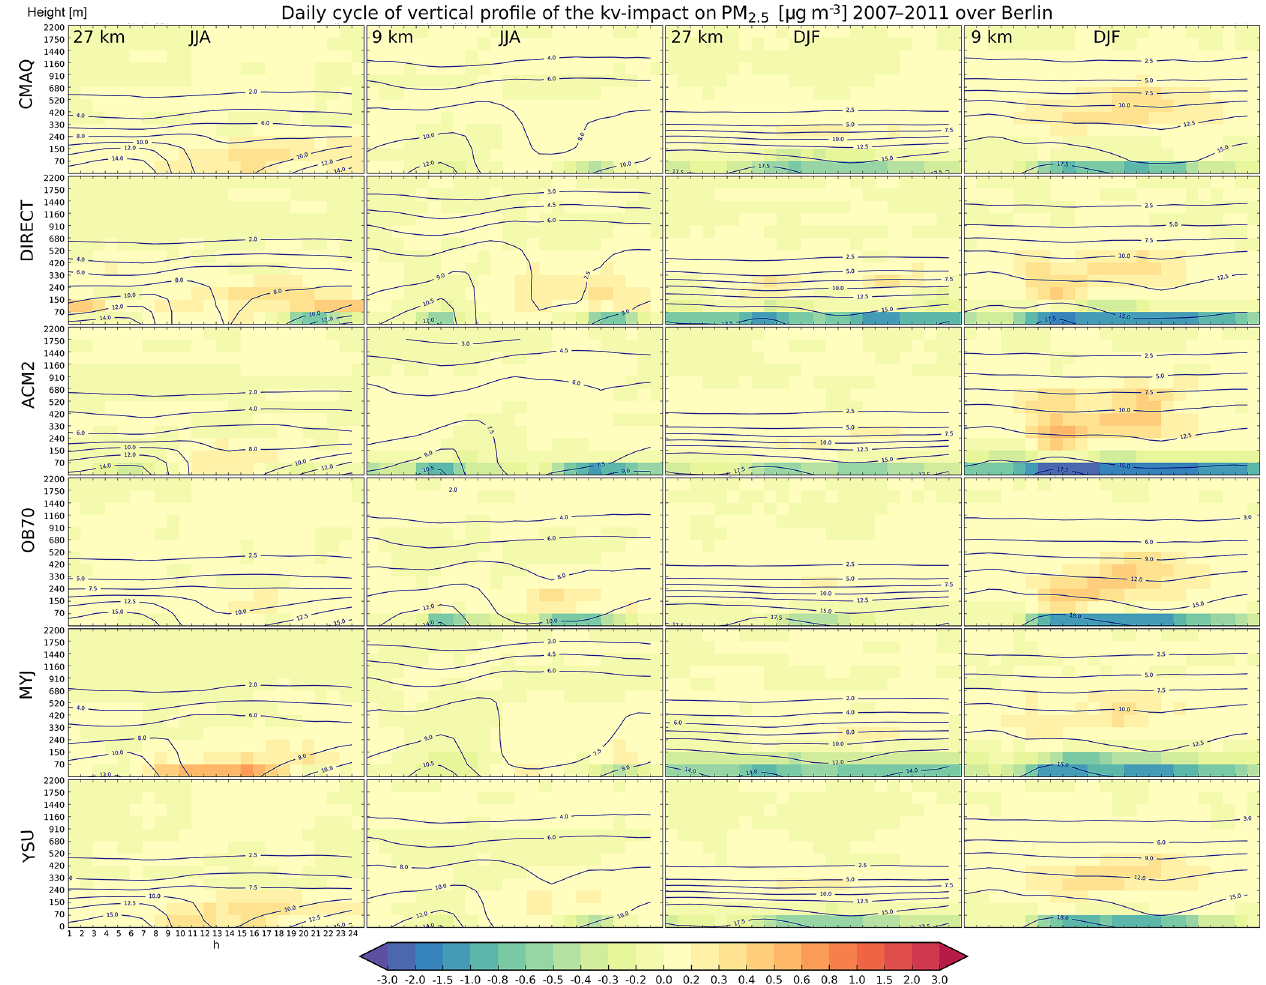
Figure 25. The impact of the urbanization-induced K v enhancement (i.e., increase of vertical eddy diffusivity) on the diurnal cycle of the PM 2 . 5 profile over Berlin for JJA (columns 1–2) and DJF (columns 3–4) evaluated over the 27km (columns 1 and 3) and 9km (columns 2 and 4) domains. Rows correspond to individual K v methods. Colors indicate the difference; contours stand for the absolute concentrations (from the total-impact). Units are in µgm − 3